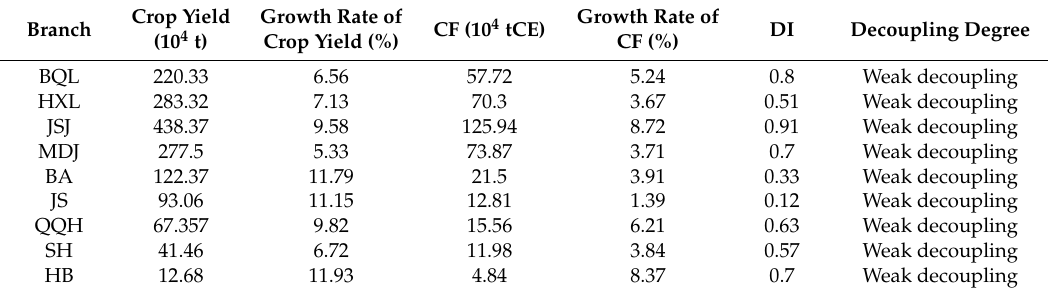
Decoupling GHG emissions from crop production in the HLRA (average of the years